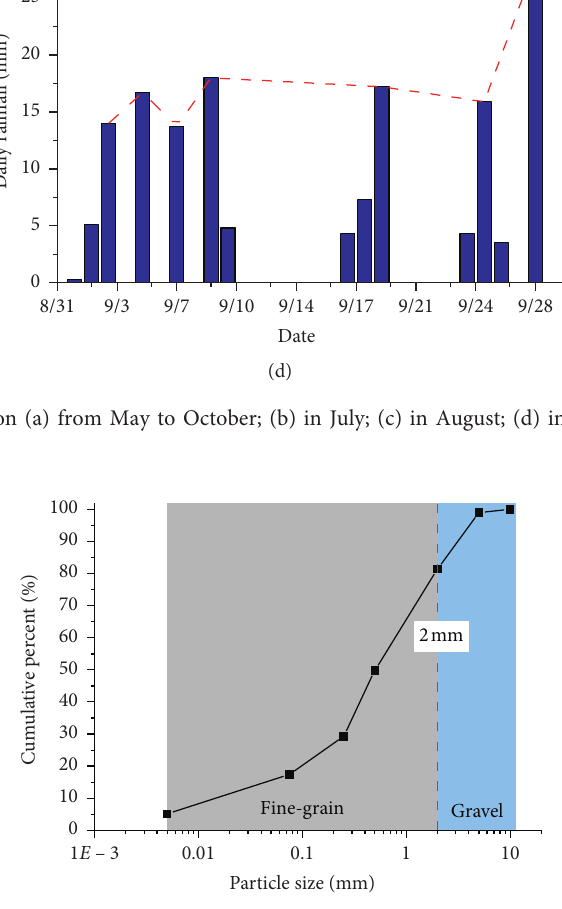
Figure 5: Grading curve of the strongly weathered silty mudstone samples. Table 1: Material